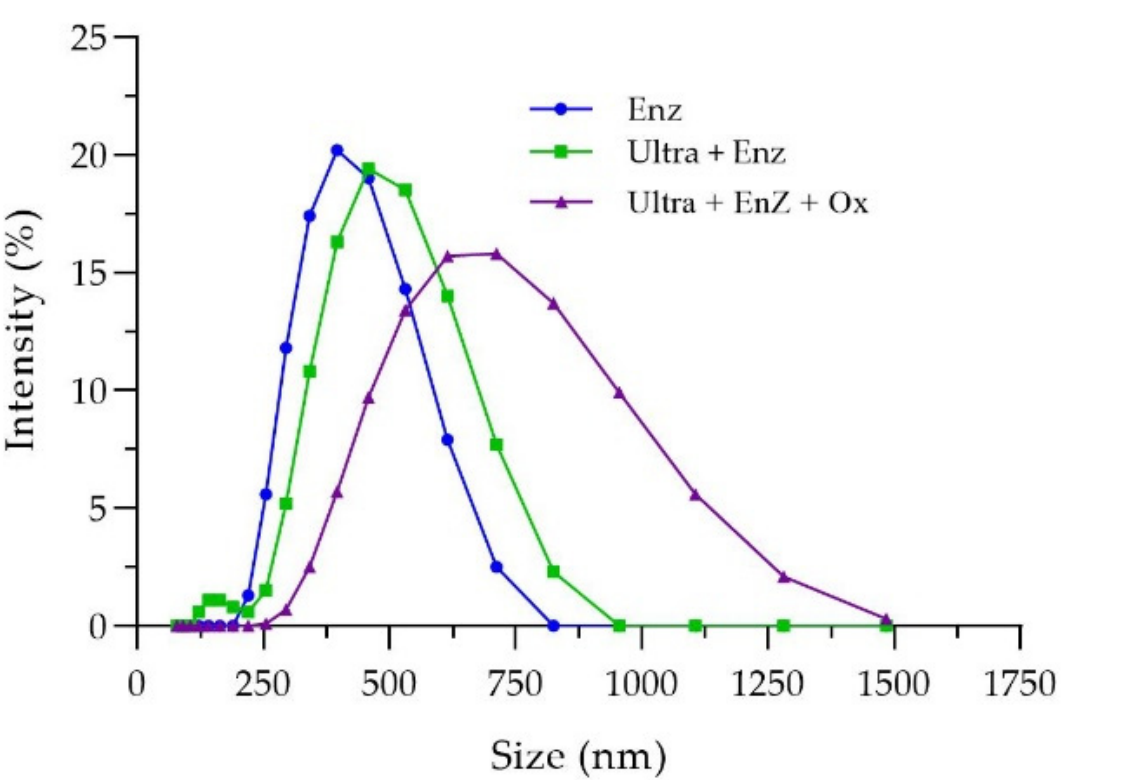
Figure 5. Particle size distributions of nanocellulose from rice straw cellulose via integrated biobased approaches; enzymatic hydrolysis (Enz), ultrasonication prior to enzymatic hydrolysis (Ultra + Enz), and intensification by oxalic acid hydrolysis (Ultra + Enz + Ox).